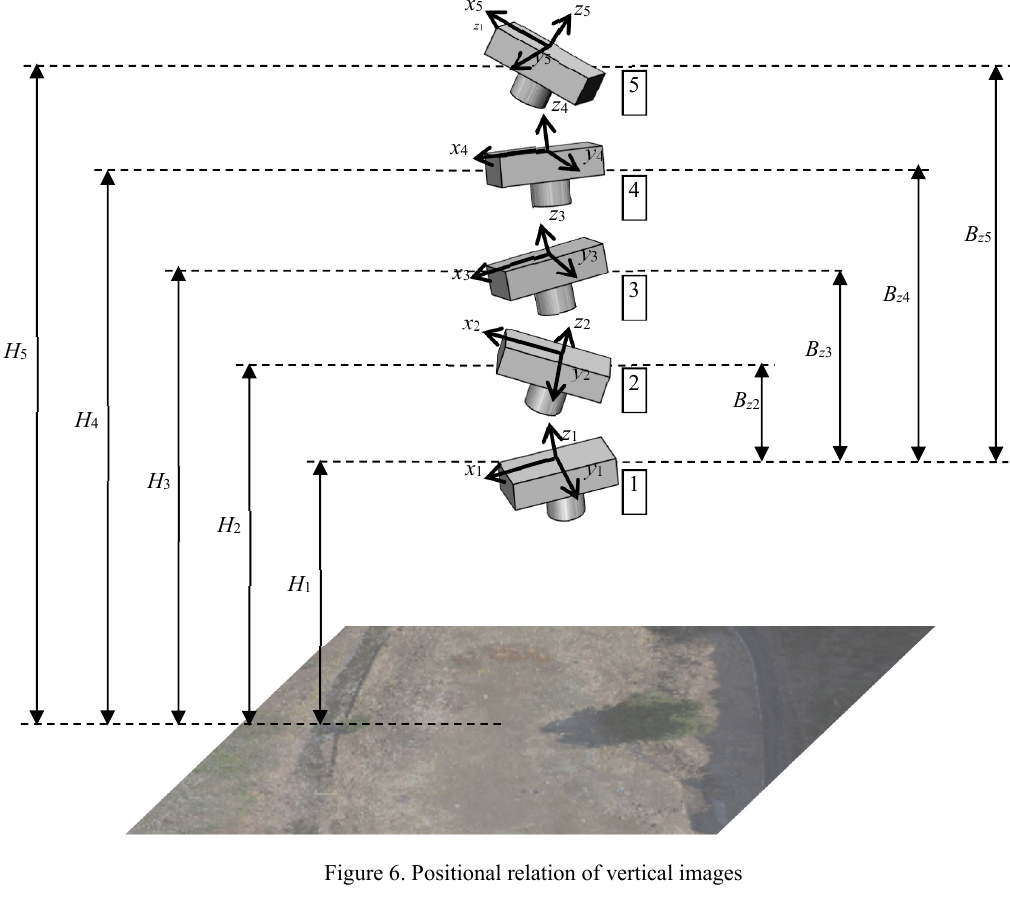
Figure 6. Positional relation of vertical Figure 7 shows coplanarity condition for images No. 1 and No. 5 of those vertical images. The epipolar plane was constituted by two principal points and a corresponding point P. Let the principal points of each image be O 1 (0, 0 ,0) and O 5 ( B x , B y , B z ), image points of P be p 1 ( x 1 , y 1 ) and p 5 ( x 5 , y 5 ). Then, the relationship of these two images is expressed by the following coplanarity equation.